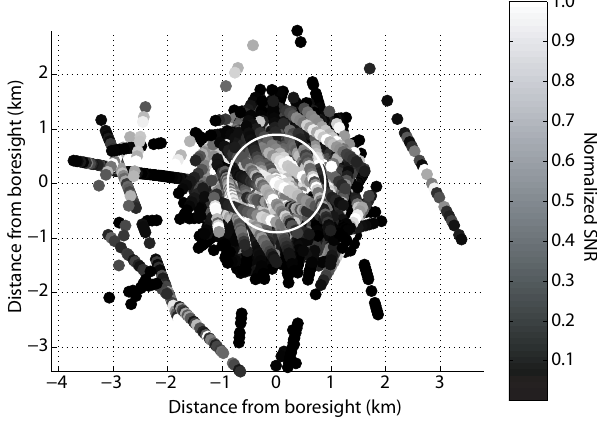
Fig. 4. The 194 meteoroid trajectories observed at autumnal equinox projected onto a plane perpendicular to the Tromsø beam. The maximum SNR of each head echo streak is normalized to one. The white circle marks the –3 dB beamwidth ( 0 . 6 ◦ ).